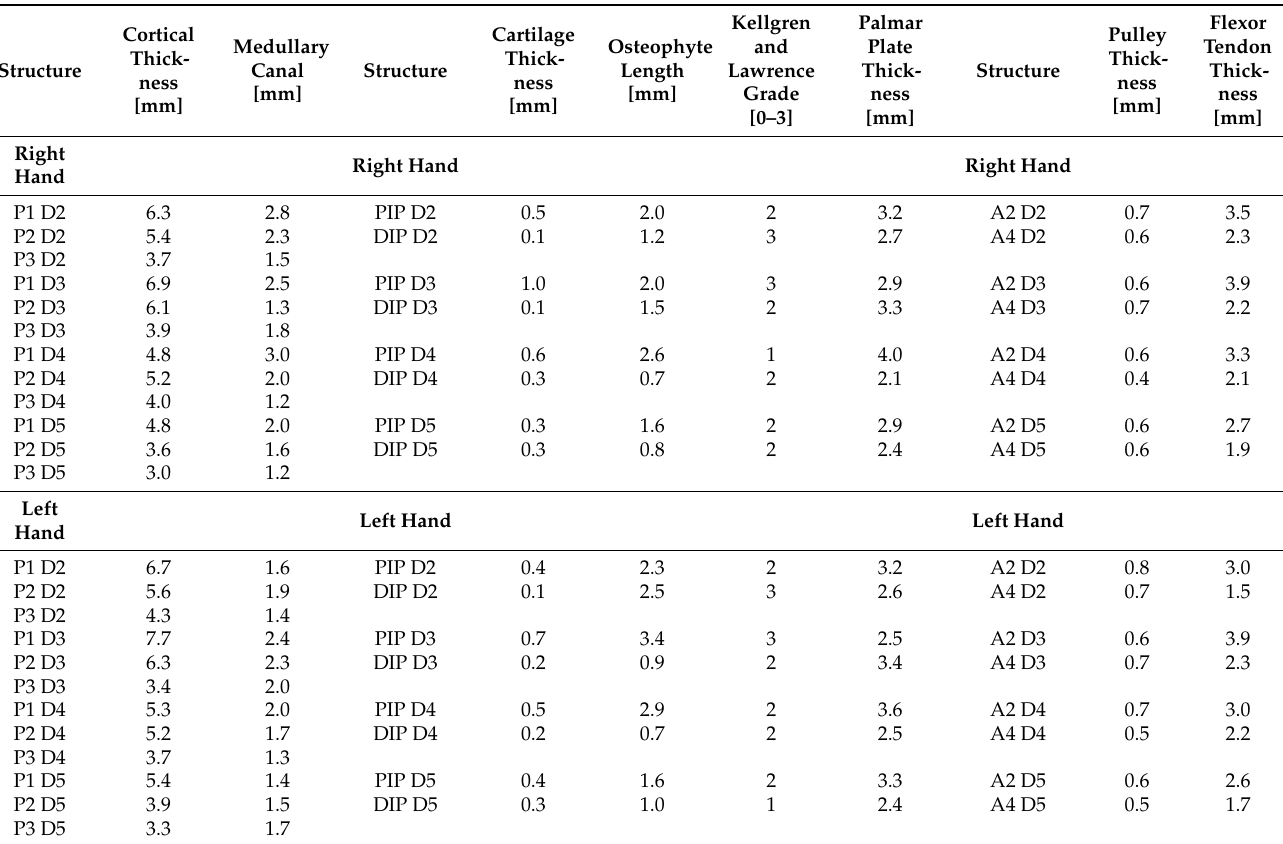
Table 3. Descriptive values for bone thickness and medullary canal diameter at phalanx 1–3 of both hands and digits II-V, as well as cartilage thickness, osteophyte lengths, palmar plate thickness and Kellgren and Lawrence Grade of PIP and DIP of both hands and digits II-V. Furthermore, pulley and flexor tendon thickness at the level of the A2 and A4 pulley of both hands and digits II-V are